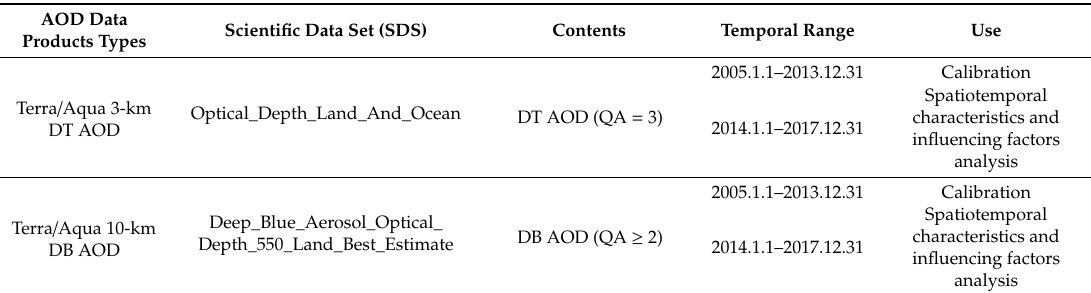
Table 1. MODIS AOD data products used in this study.